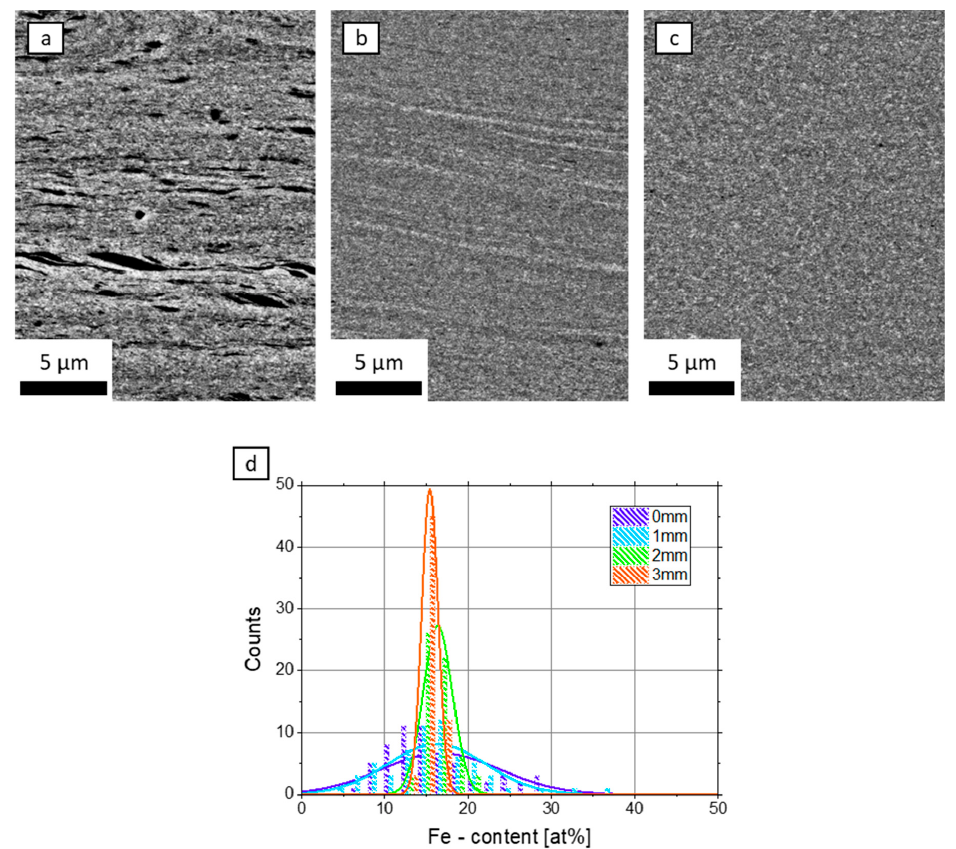
Figure 5. SEM micrographs of the sample containing Cu 85 Fe 15 at ( a ) r ~ 0 mm, ( b ) r = 1 mm, ( c ) r = 2 mm, from left to right (No. rotations = 100). The progressing dissolution of Fe into the Cu matrix can be seen. ( d ) Distribution of EDX-results for the same sample and for different radii. 60 spectra were recorded at each position. As a guide for the eye, a normal distribution was fitted to the data.